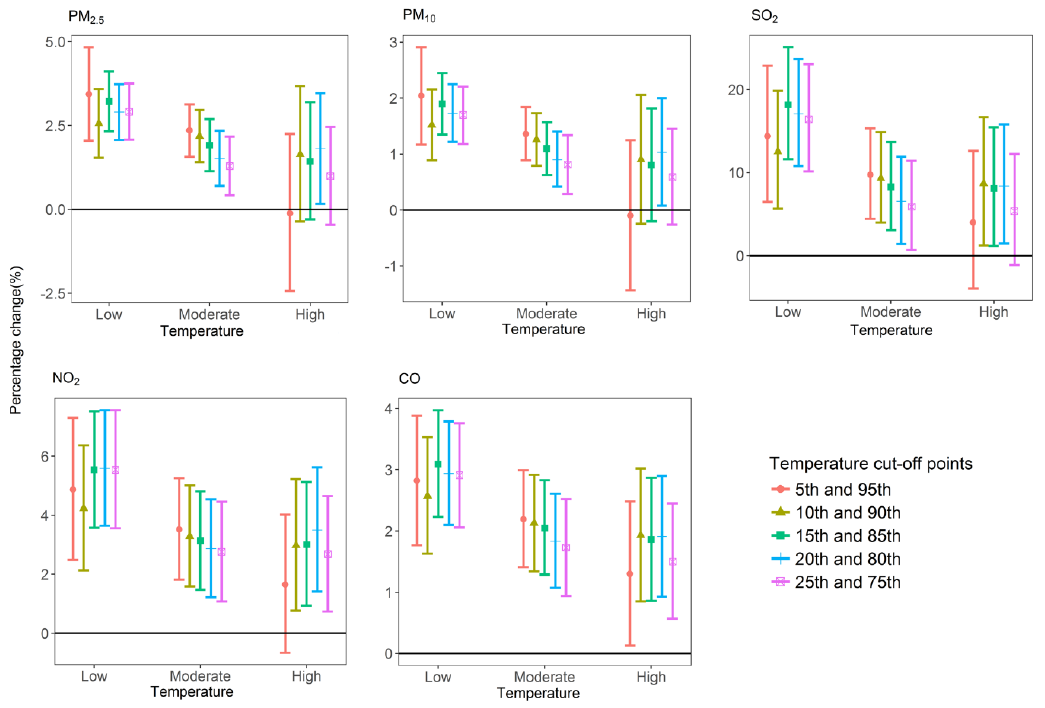
Figure 2. Associations between daily air pollutant concentrations and COPD HAs stratified by varying percentiles of temperature cut-off points.